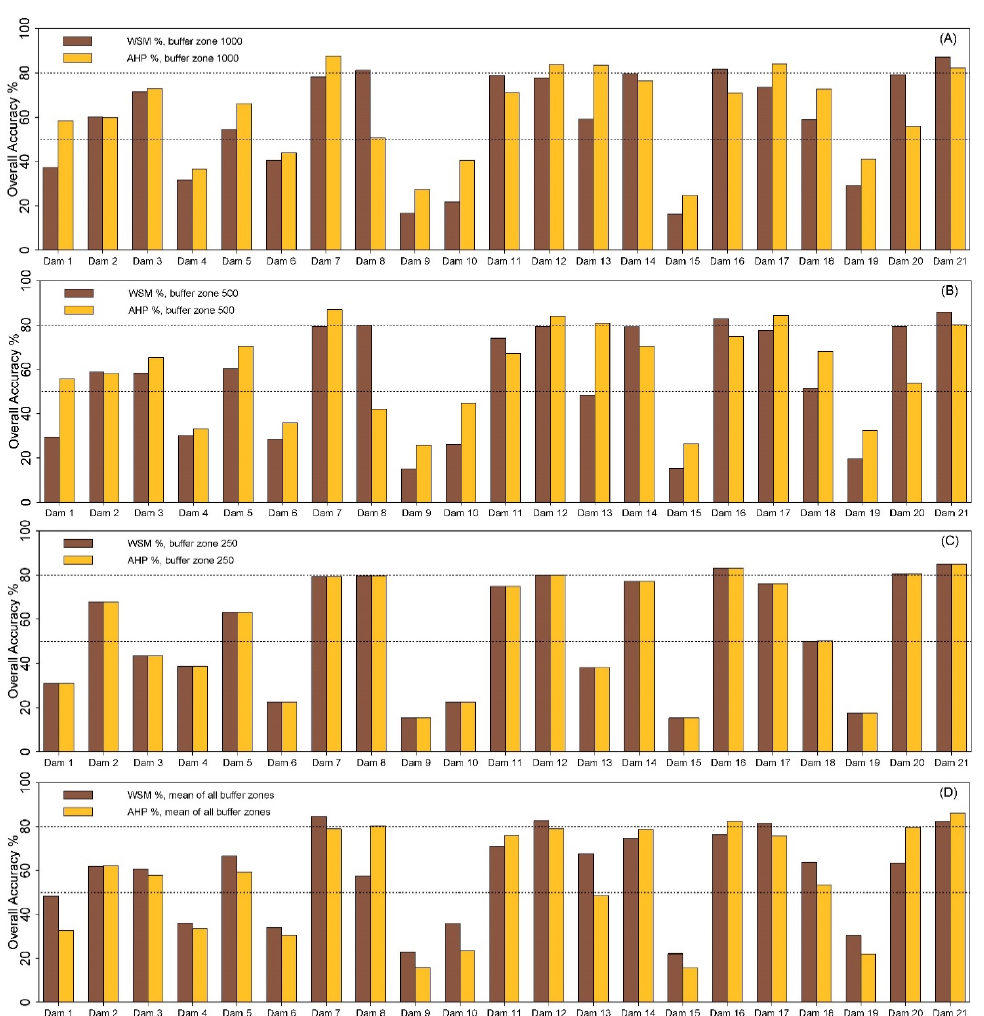
Figure 14. Overall accuracy of the SWM and AHP models of the ( A ) buffer zone 1000 m, ( B ) buffer zone 500 m, ( C ) buffer zone 250 m, and ( D ) mean of all buffer